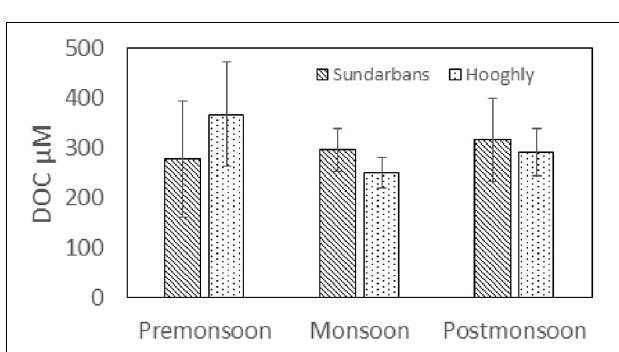
FIGURE 9 | Seasonal variation of mean DOC concentration ( µ M) for both the Hooghly and Sundarbans estuaries.